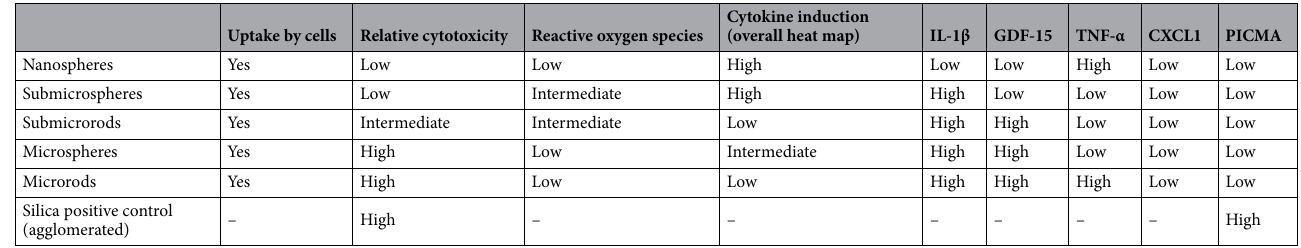
Table 3. Summarized effects of silica particles on NR8383 alveolar macrophages. All data are relative within the five particle types and the positive control.